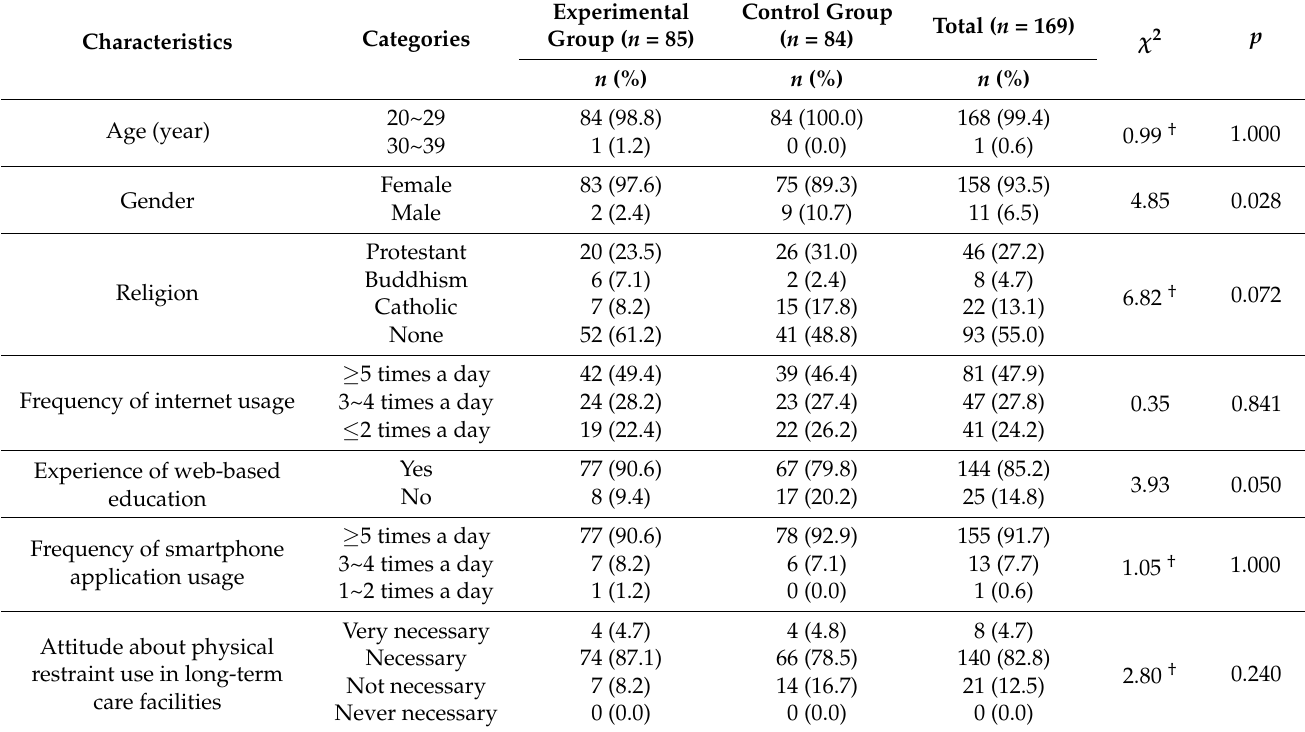
Table 1. Participants’ general characteristics and homogeneity test between groups ( n = 169).